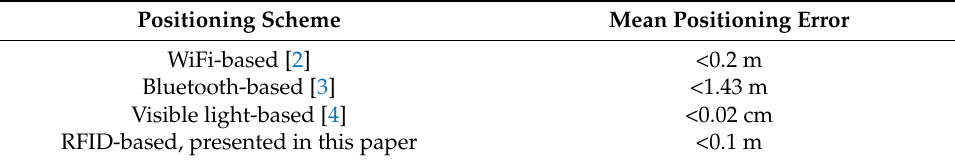
Table 1. Indoor positioning accuracy with different typical positioning schemes.